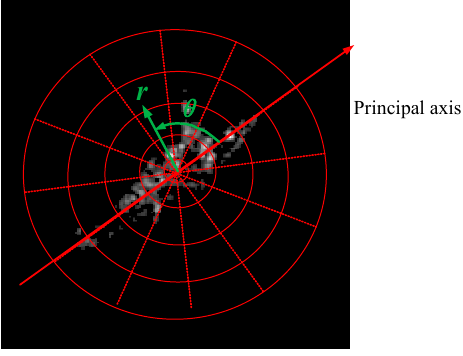
Figure 5. Shape contexts description based on principal axis.